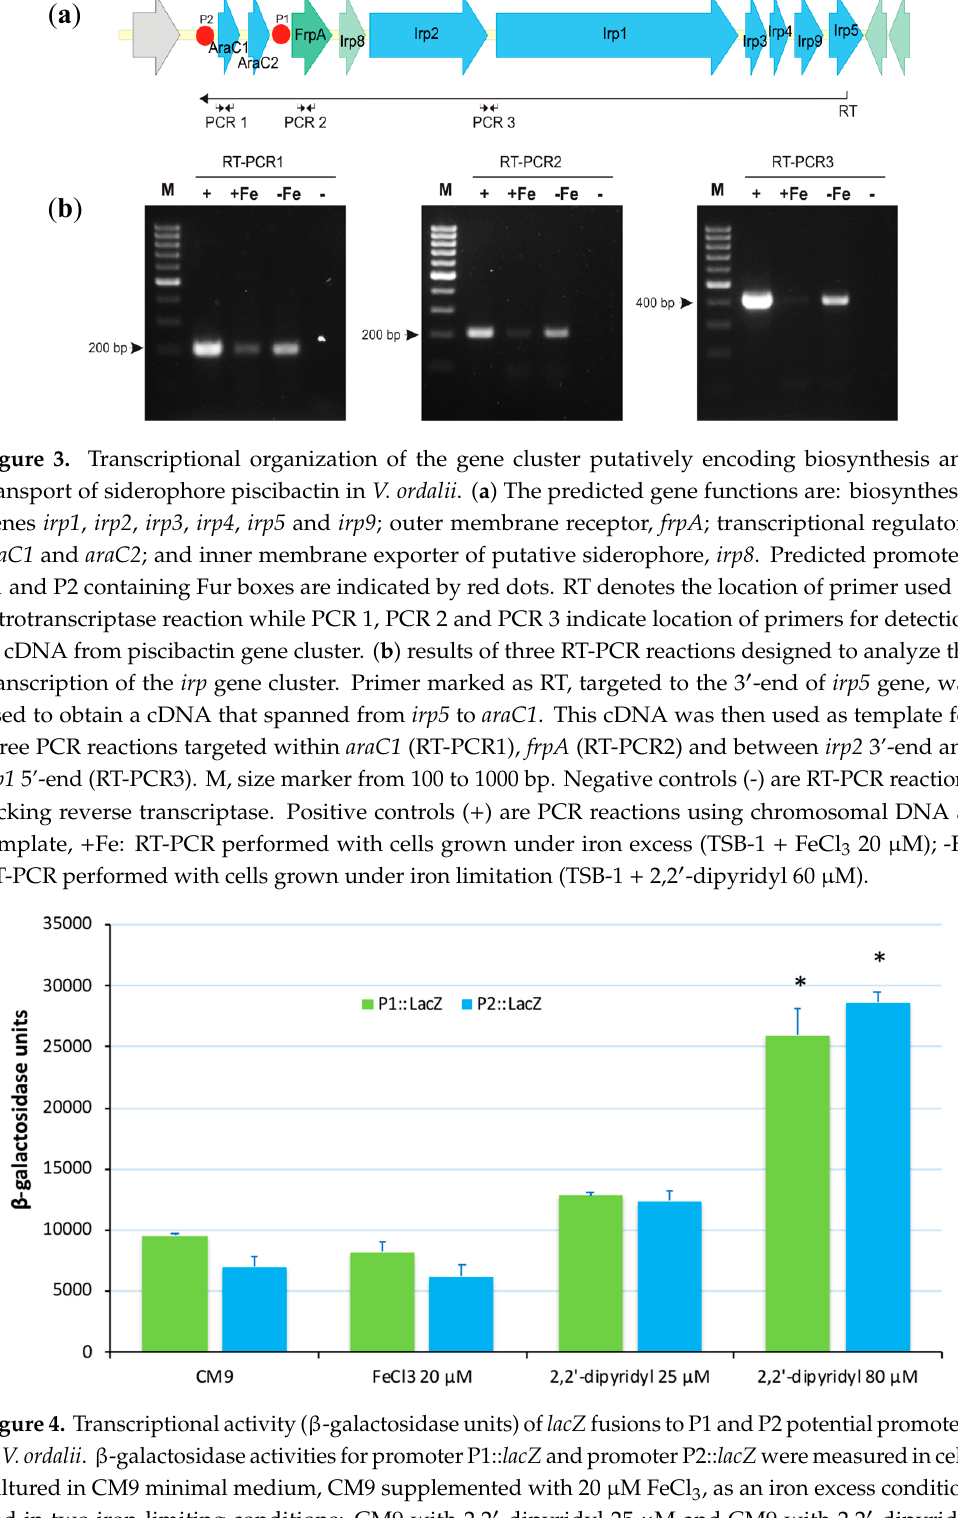
using ANOVA significance test (* p <